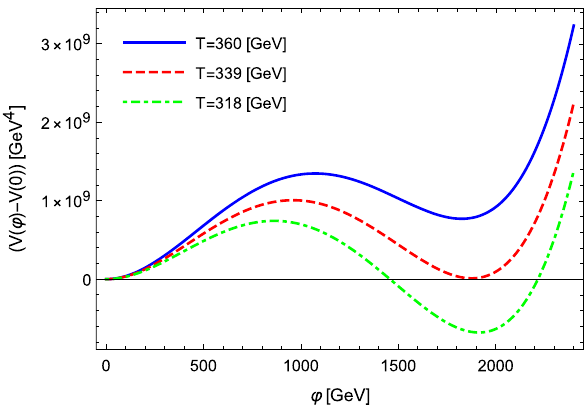
Fig. 4 The effective potential which accounts for the full 1-loop ther- mal effects including the re-summed daisy diagrams plotted for three different temperatures. At the critical temperature T c = 339GeV the minima at ϕ = 0 and ϕ (cid:8) 1900GeV are degenerate where V high − T is derived from Eq. (18) using high temper- ature approximation (20) with only x 2 term,